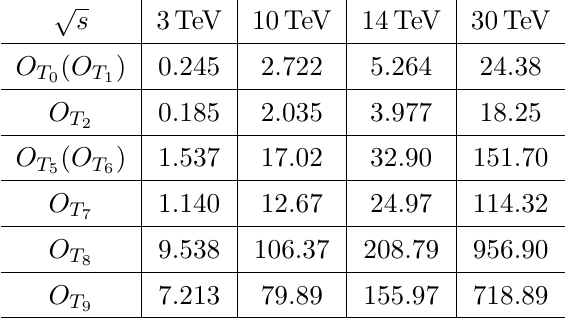
Table 4 . The fitted values of ˆ σ int ( fb × TeV 4 ) for different